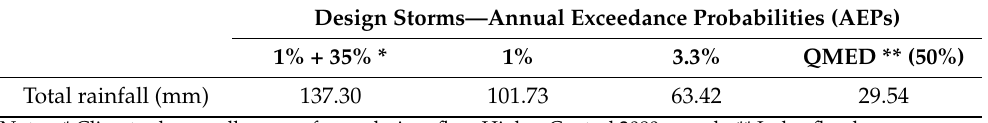
Table 1. Characteristics of flood estimation handbook (FEH) rainfall-runoff hydrographs for 12 h storm duration events.